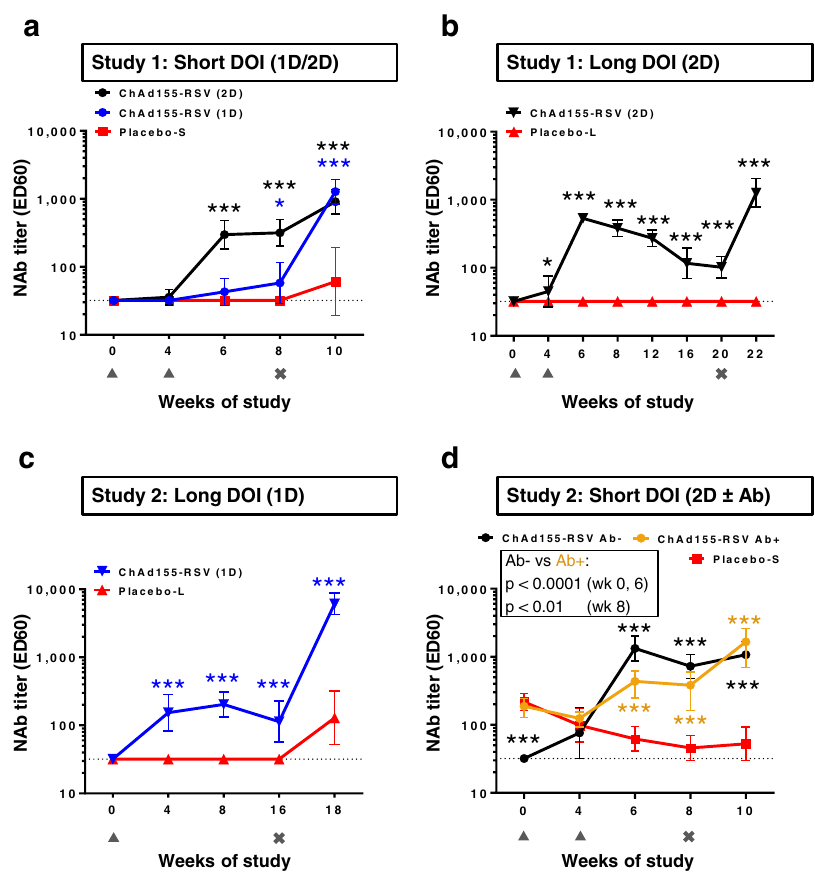
Fig. 6 | Human RSV A-speci fi c nAb titers. Human RSV subtype A (hRSV A) neu- tralizing antibody (nAb) titers are presented. Titers are expressed as the inverse of theserumdilutioncausing60%reductioninthenumberofplaquesascomparedto theviruscontrolwells(ED 60 ).Geometricmeanswith95%con fi denceintervals(error bars) for each group are color coded according to the keys in each graph. Calves ( n =7 – 9 biologically independent animals, see Table 1) received a single or two doses (1D or 2D, respectively) of ChAd155-RSV vaccine or placebo, followed by a short(4weeks, a , d )orlong(16weeks, b , c )durationofimmunity(shortDOIorlong DOI, respectively), and then a bovine RSV challenge. Placebo-S and placebo-L groups indicate the control groups subjected to the short-DOI and long-DOI regi- mens, respectively (note that the sample sizes of the placebo-L and placebo-S groupsinStudy2decreasedpost-challenge;seeFigs.3and5,respectively).Groups